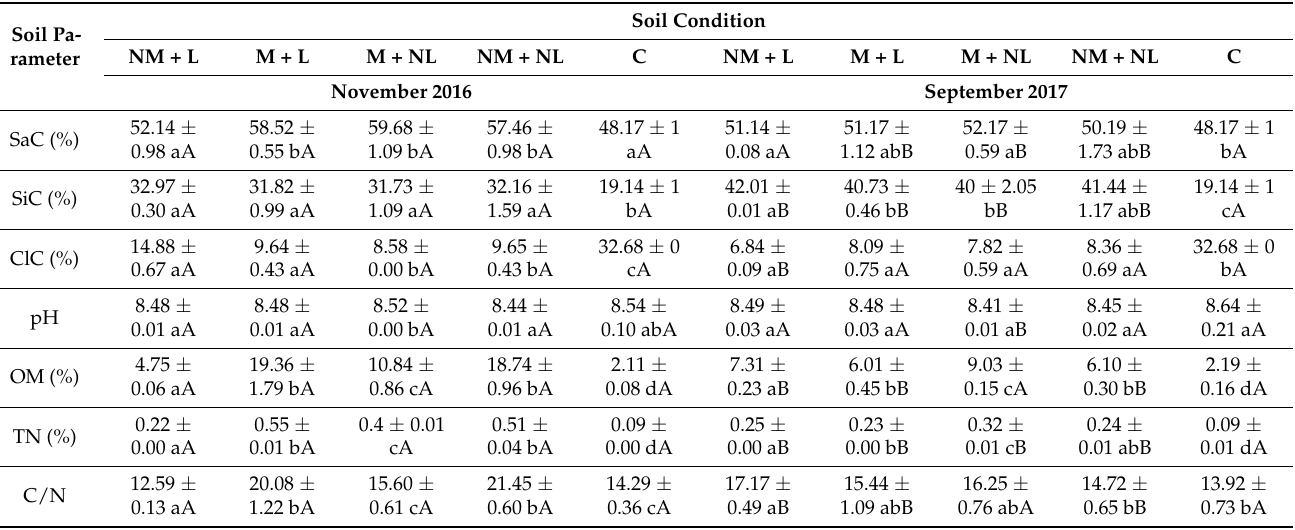
Table 3. Main soil parameters that were measured at two dates under five soil conditions in the experimental site (Li é tor, Castilla La Mancha,